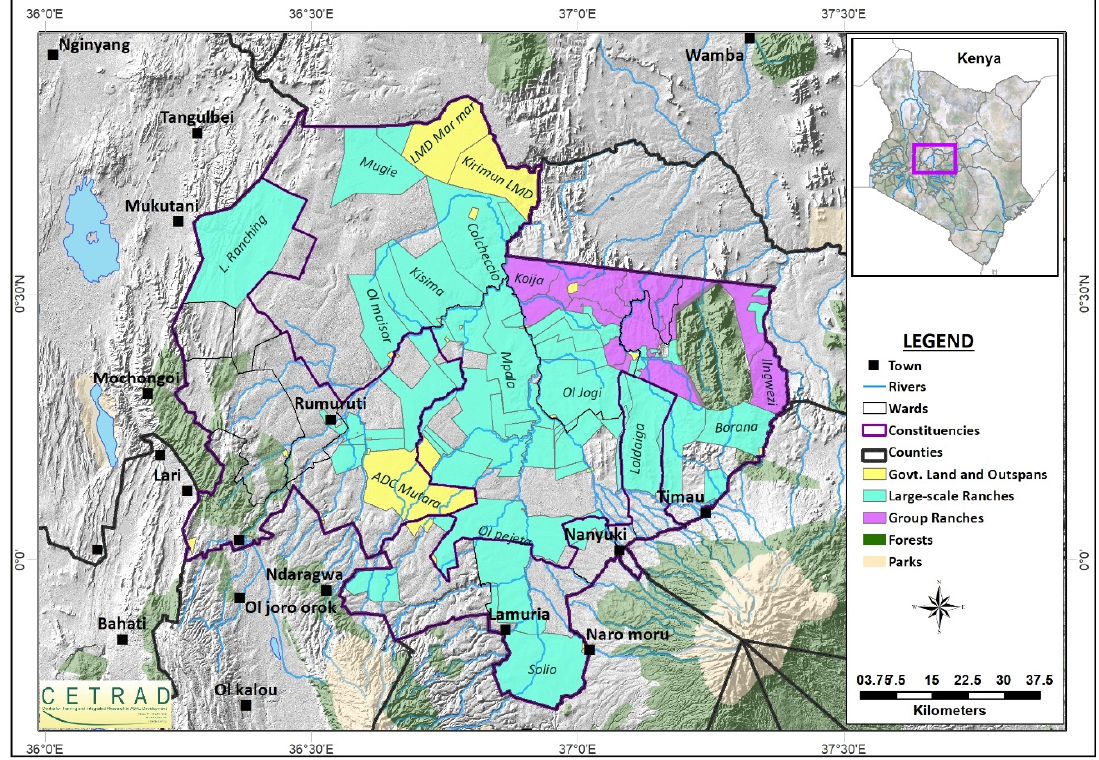
Figure 1. The Study Area. The sampled large-scale ranches bordered the group ranches that host the pastoralists. (Source: Centre for Training and Integrated Research in ASAL Development).